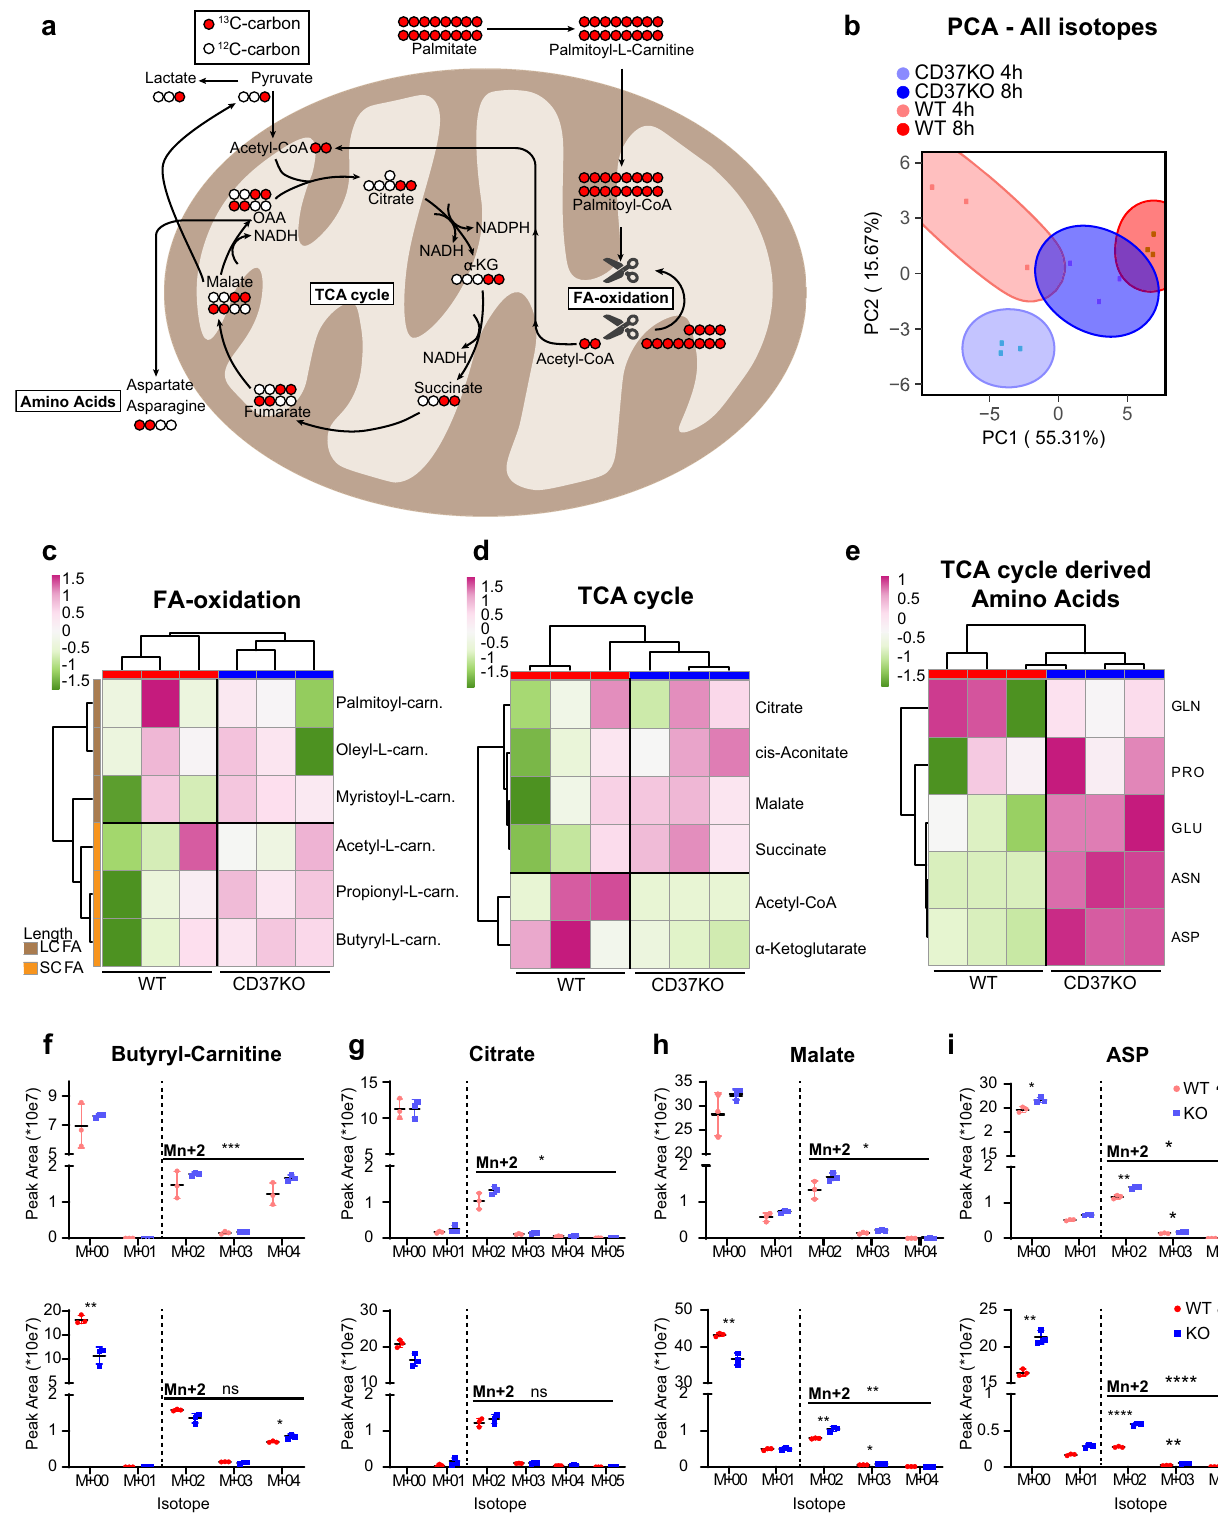
fatty acid transporters in primary B cells revealed prominent expres- sion of fatty acid transporter protein 1 ( Slc27a1 , FATP1) and of CD36 (Fig. S4M). Quanti fi cation of FATP1 and CD36 protein expression on the surface of WT and CD37KO lymphoma cells revealed no difference between these cell genotypes (Fig. S4N, O). However, dual labelling of CD37 and the palmitate transporters revealed obvious colocalization between CD37 and FATP1 (Pearson ’ s R =0.71), but signi fi cantly less